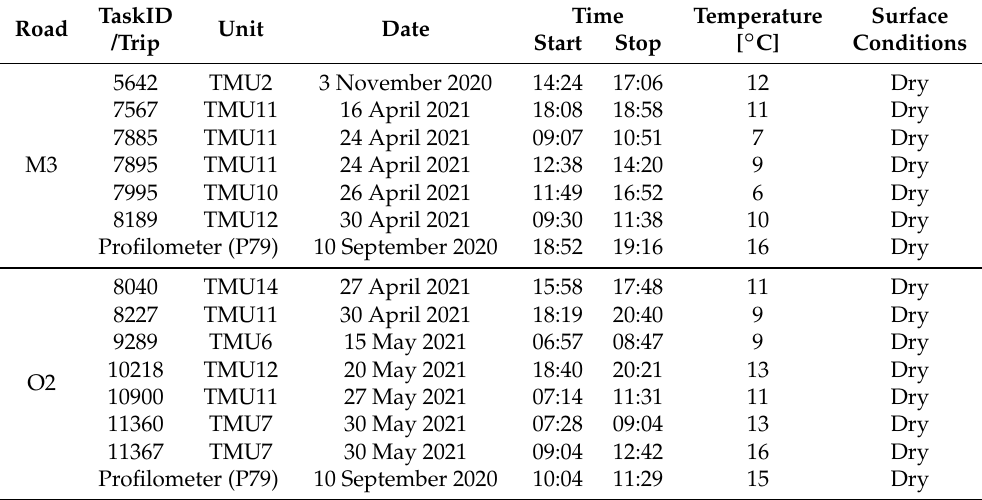
Table 5. Overview of measurement campaigns.